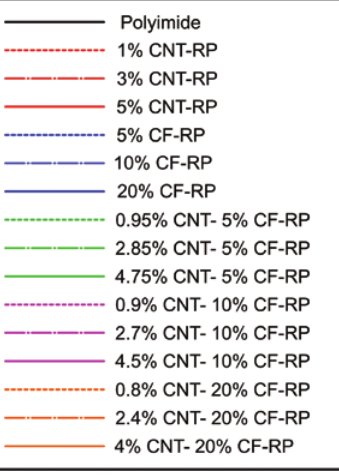
Figure 8: Legend of Figures 5–7.